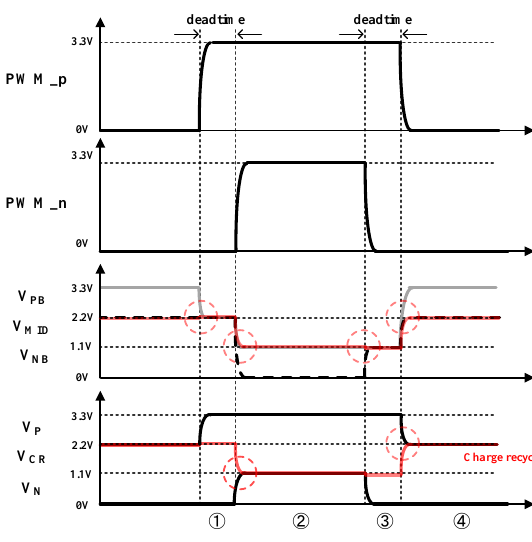
Figure 3. Timing diagram of the proposed gate driver.